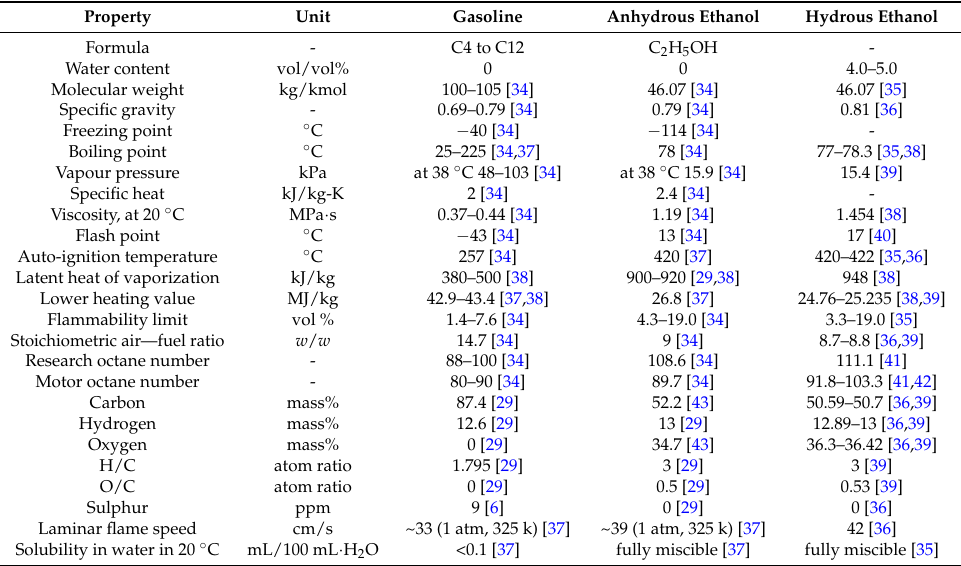
Table 1. Comparison of gasoline, anhydrous ethanol and hydrous ethanol fuel